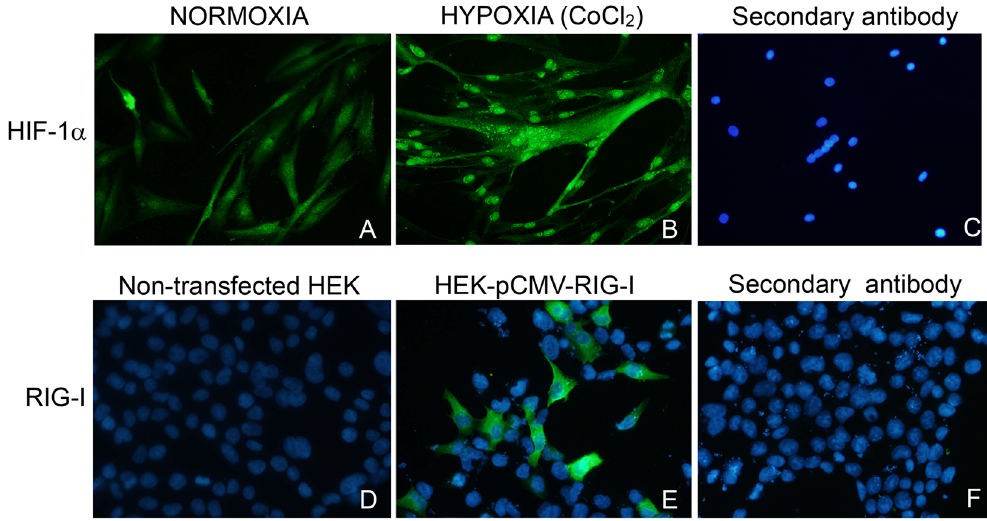
Figure 7. Positive and negative controls for HIF-1 α and RIG-I stainings. Human myotubes cultured with CoCl 2 induce the translocation of HIF-1 α to the nucleus. HEK-293 cells were transfected with pCMV-RIG-I. Magnification ×